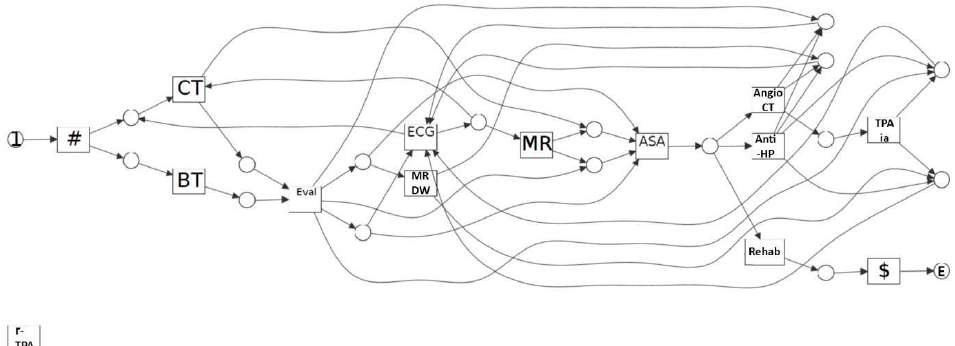
Figure A1. Process model generated by the Alpha plugin. The place indicated as “1”, followed by the action “#” represents the starting place and action of the model, while the “E” followed by “$” represents the ending (final) state and the final action of the model.